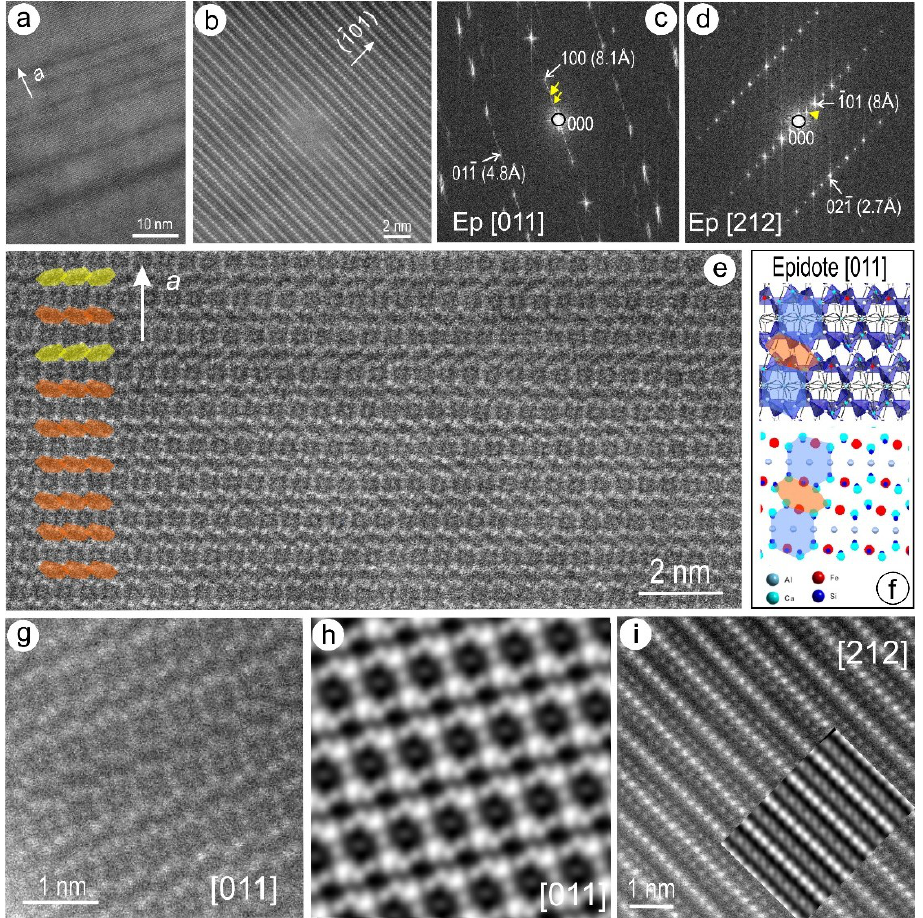
Figure 16 . HAADF STEM ( a , b ) images and FFTs ( c , d ) showing epidote (Ep) on [011] and [212] zone axes (inclusion in Figure 14h; foil #4). Note correlation between irregular bands on ( a ), satellite reflections (arrowed) and streaks along a* indicating stacking disorder. ( c ) High-resolution image showing the main crystal structural motifs on [011] epidote. ( f ) Crystal structure models of epidote as polyhedral (up) and atom filling (down) on [011} zone axis. Note correspondence between ring structure and main motifs on ( e ). The smaller modules linking the rings are irregularly flipped (yellow and red overlays), indicating disorder on a . ( g , h ) Image and STEM simulation of epidote on [011]. ( i ) Image and STEM simulation (inset) of epidote on [212] zone axis.